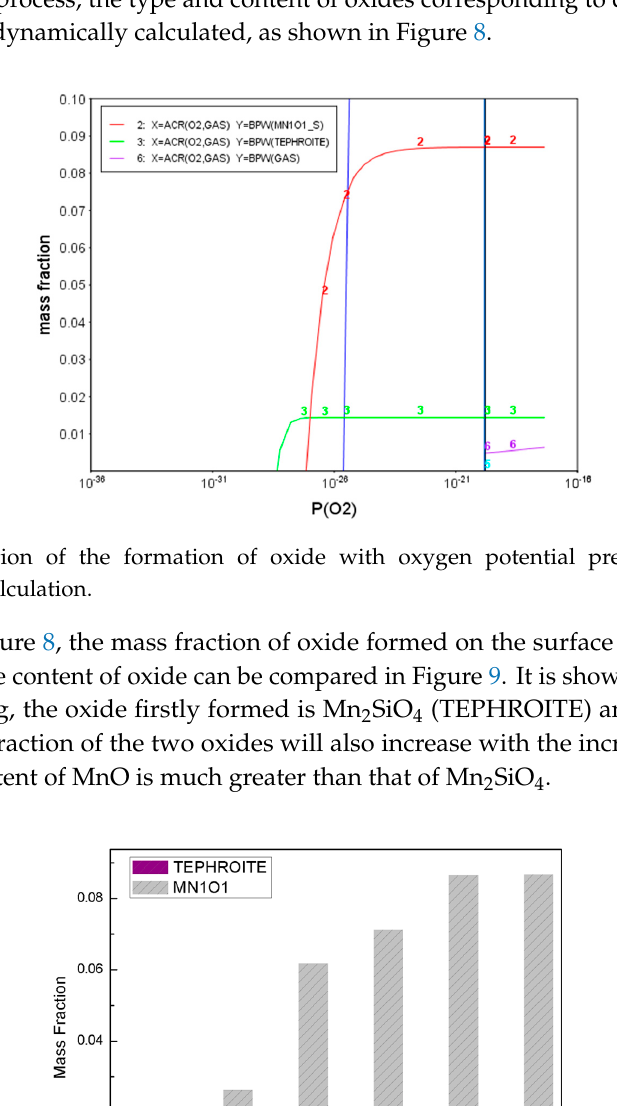
Figure 9. Comparison of the content of oxide on the samples according to thermodynamic calculation.